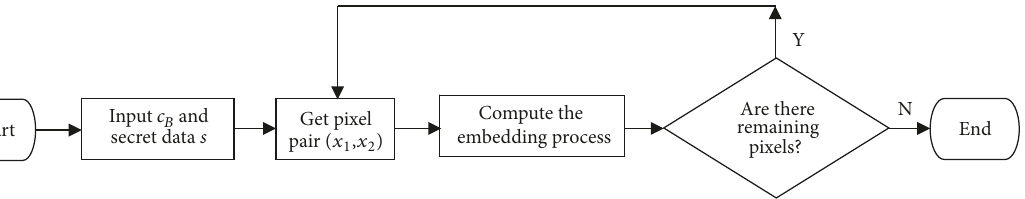
Figure 2: The embedding